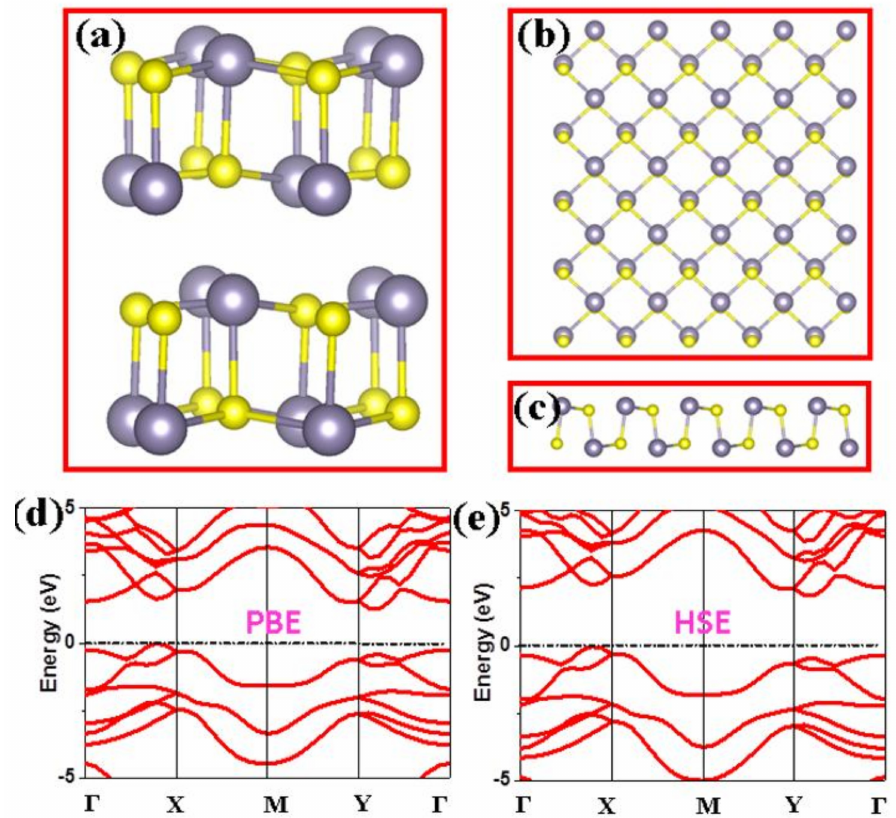
Figure 1. The crystal structures for ( a ) 3D bulk SnS; ( b ) top view of 2D SnS monolayer; ( c ) side view of 2D SnS monolayer; The calculated band structure of 2D monolayer with PBE ( d ) and HSE ( e ). The Γ -X-M- Υ - Γ means the high symmetric points in Brillouin